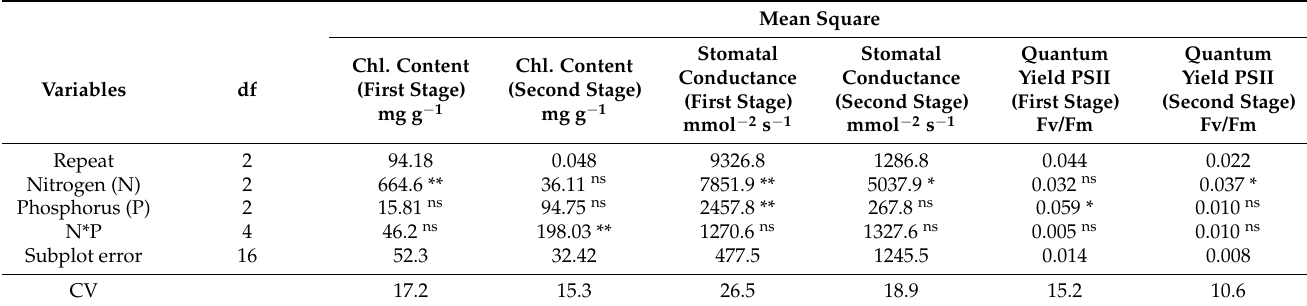
Table 2. Variance analysis of some physiological characteristics of rapeseed under N and P levels.